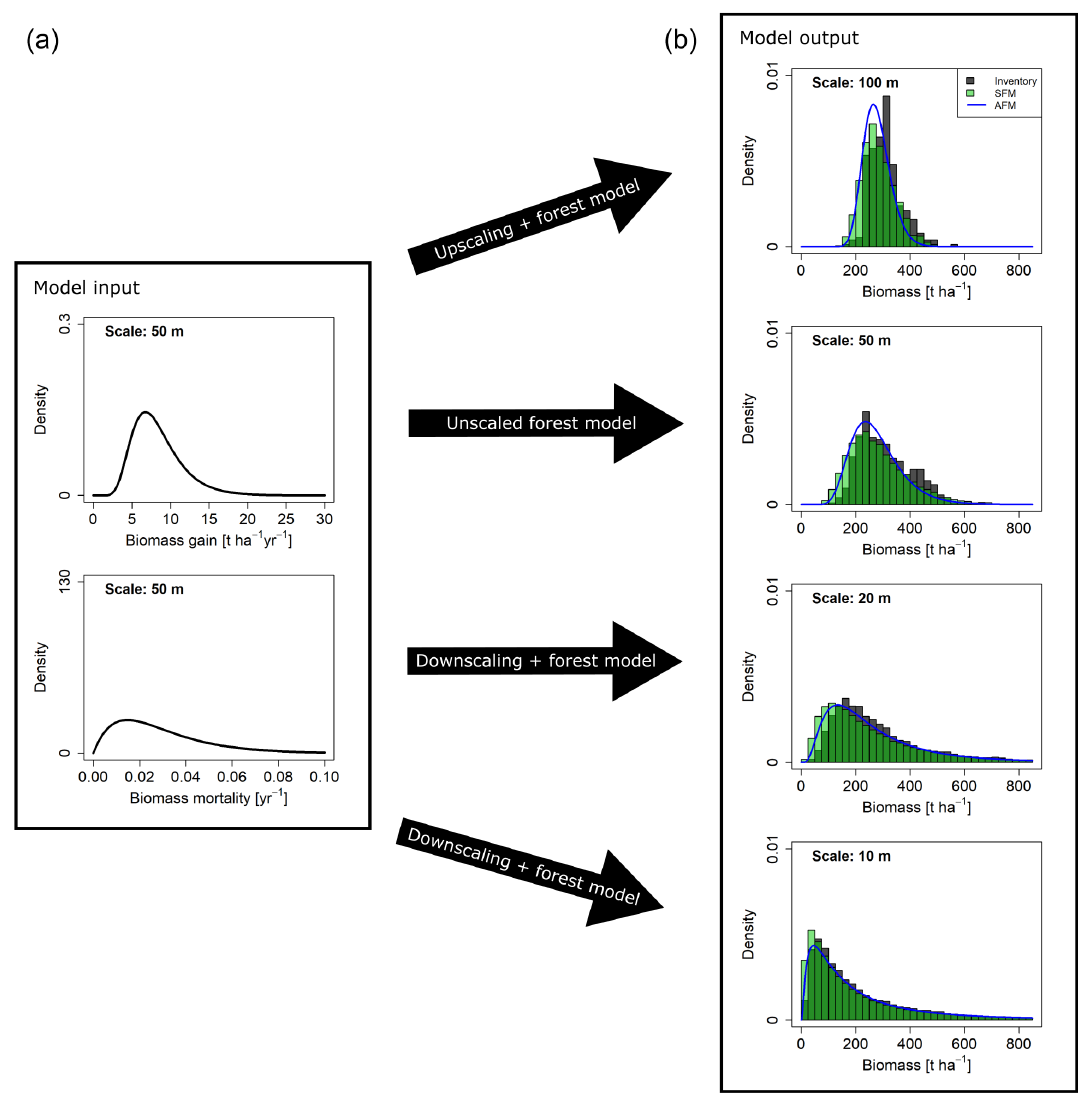
Figure 6. Biomass distributions at different spatial scales resulting from different approaches. (a) Curves show the gain ( G ) and mortality ( M ) distributions used as input. (b) Dark grey histograms show the empirical distributions from the field inventory. Green histograms show the simulation results from the stochastic forest model (SFM). All SFM simulations were driven by the two probability density functions for AGB gain and mortality derived at the 50m scale (a) , which were rescaled for simulations at the 10, 20 and 100m scale. Blue lines show the AGB distribution functions calculated with the analytical forest model